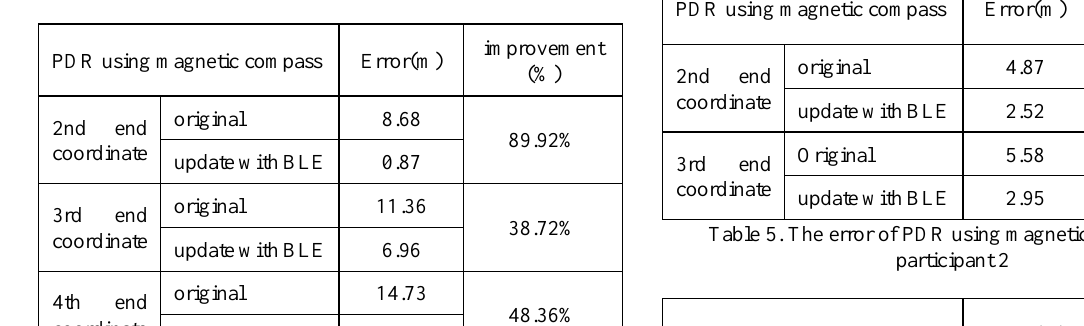
Figure 9 . The trajectory of participant 1